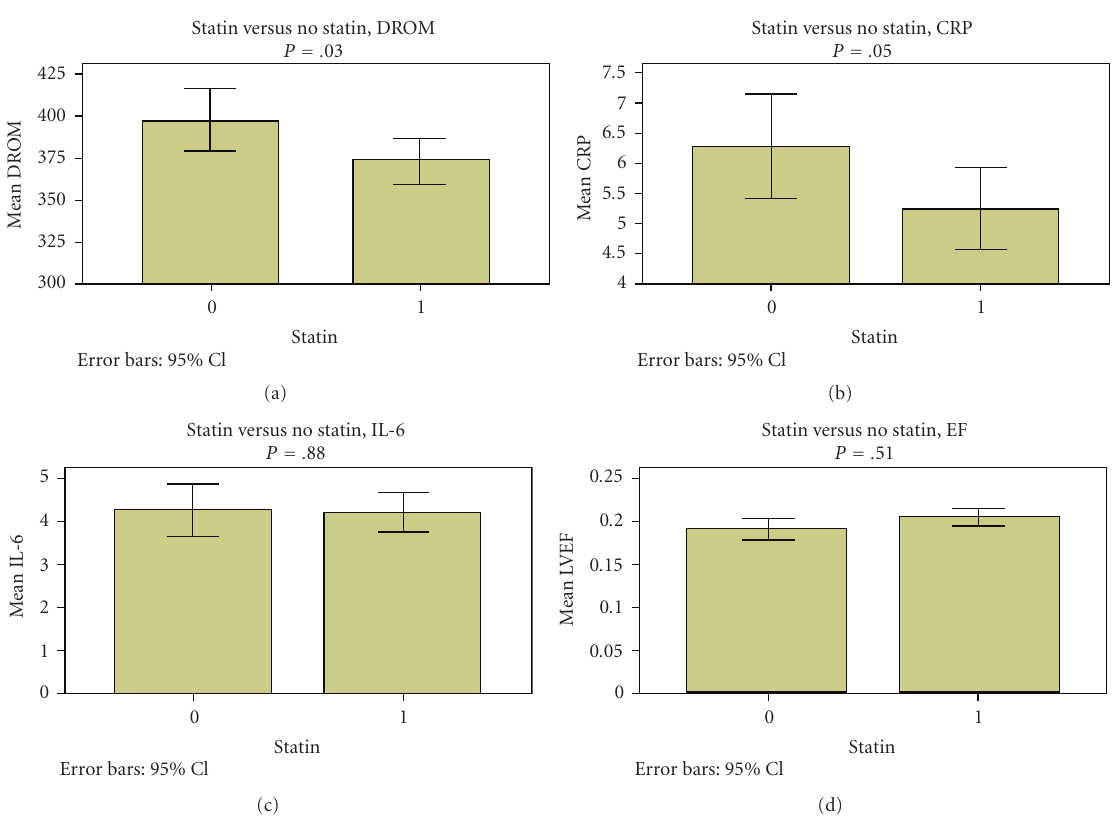
Figure 1: Comparison of mean DROM, CRP, IL-6 and EF by statin use or non-use with respective P values. Statin use = 1, non-use = 0.